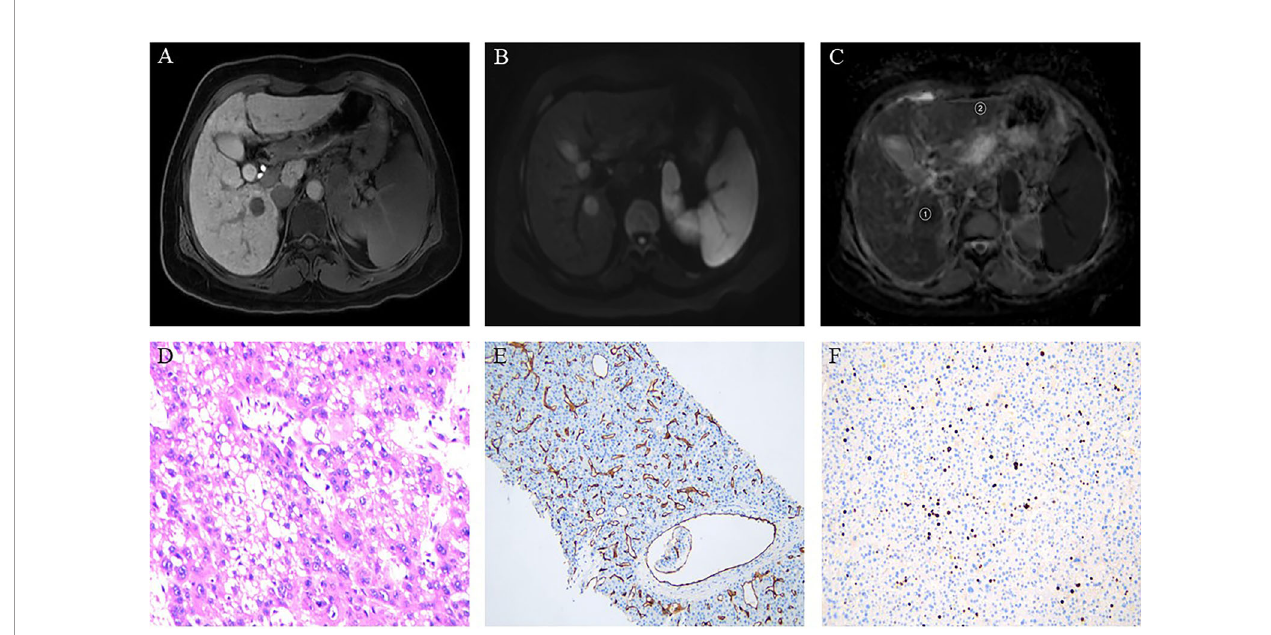
FIGURE 2 | Hepatocellular carcinoma in a 49-year-old woman showing a round segment VI mass in the liver. (A) Axial lesions in the hepatobiliary phase showing low signal intensity relative to the hepatic parenchyma. (B) Diffusion-weighted imaging axial lesions showing high signal intensity. (C) Apparent diffusion coef fi cient (ADC) map showing the regions of interest used to determine the average ADC (1), and the ADC in normal-appearing hepatic parenchyma (2). (D) Pathology revealing poorly differentiated hepatocellular carcinoma (HE×400). (E) Immunohistochemistry showing microvascular invasion. (F) Immunohistochemistry showing high proliferative activity of tumor cells with approximately 20% Ki-67 expression.